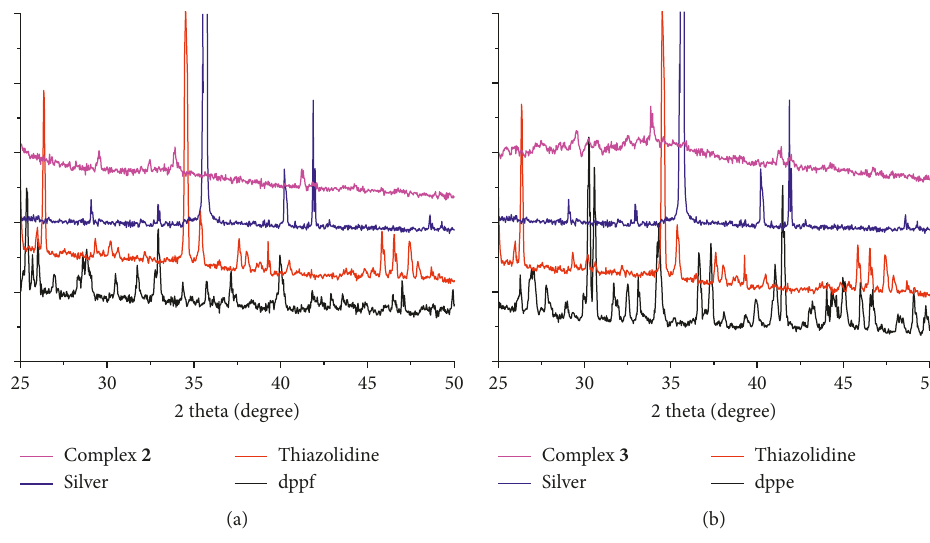
Figure 2: PXRD diffraction patterns of complexes 2 and 3